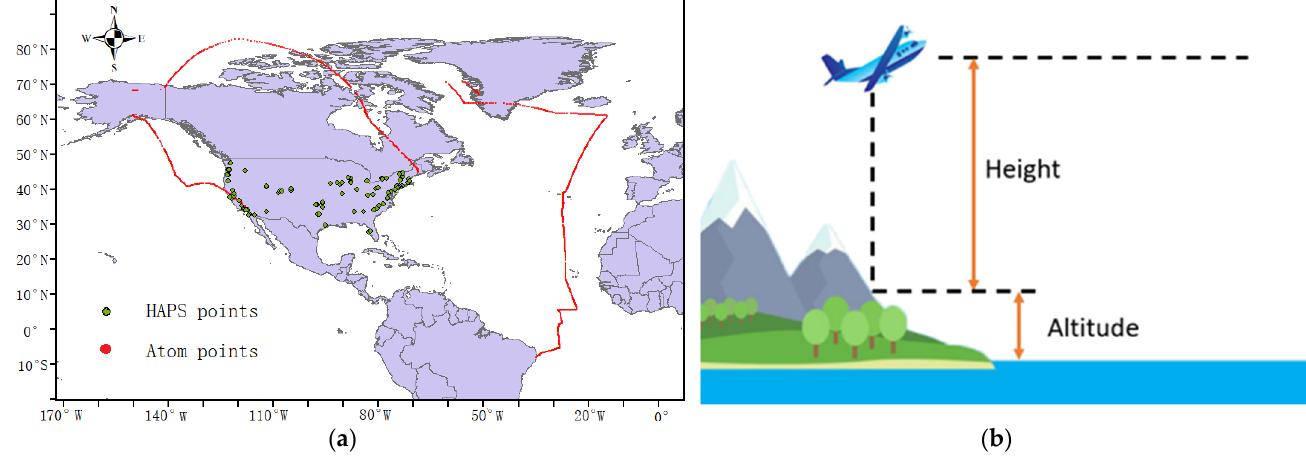
Figure 3. (a) The geographical distribution of our data, where red represents ATom aerial in-situ data points and green represents HAPs ground monitoring network. (b) The meaning of “Height” and “Altitude” for ATom mission data.